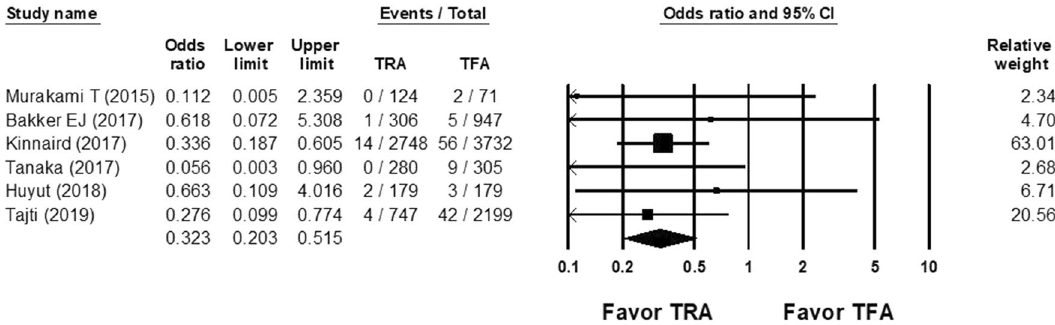
Figure 4. Forest plots of the OR of vascular complication of CTO PCI between the TRA and TFA groups from 6 studies.